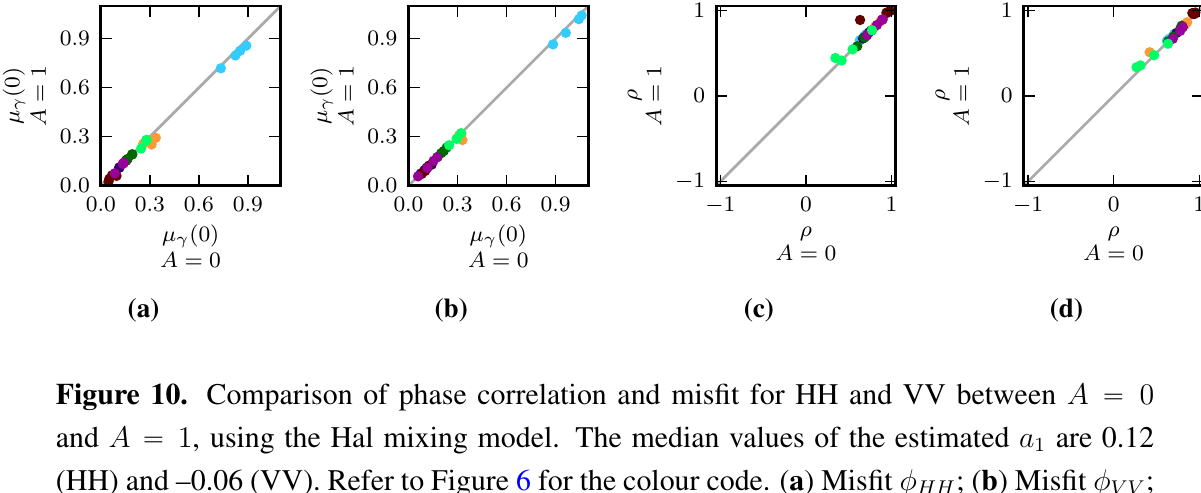
are 0.12 1 ; ( b ) Misfit φ ; HH V V